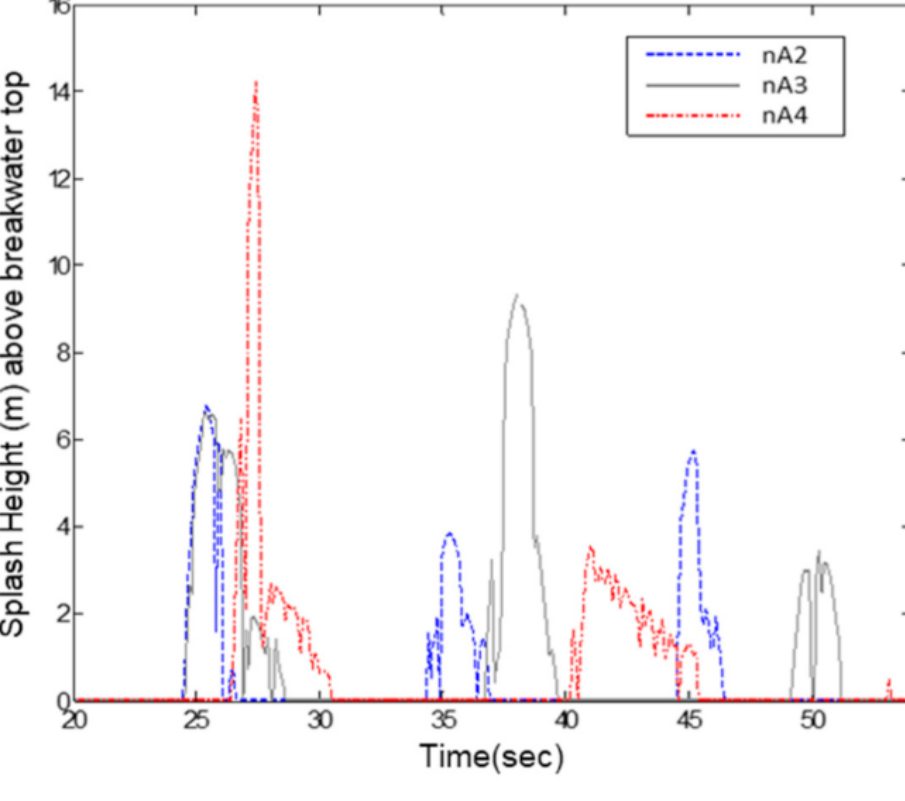
Figure 8. Time series of the splash heights triggered by CFW when armor blocks are not installed (cases nA2, nA3 and